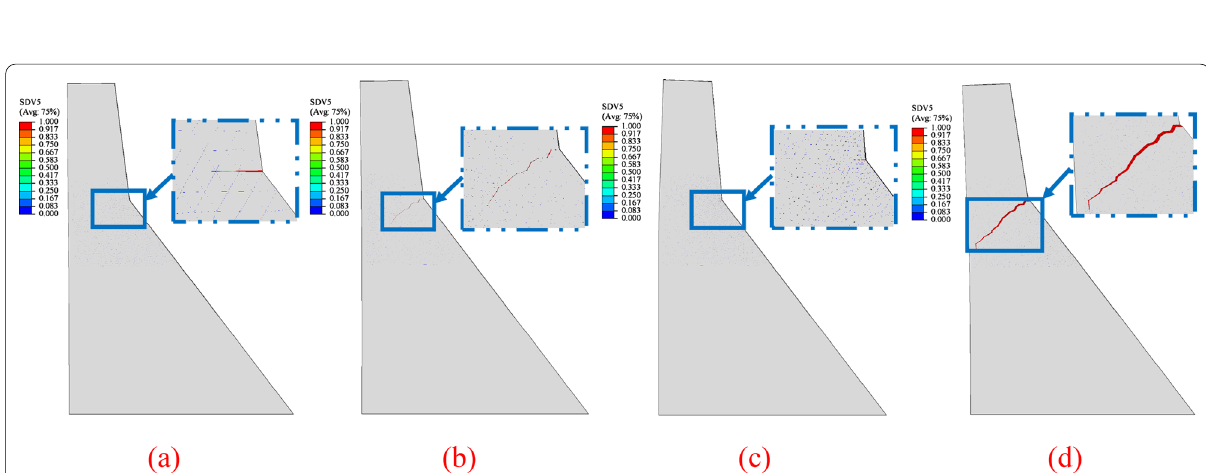
Fig. 25 SDV5 nephograms of the Koyna gravity dam without longitudinal crack at different times: a t